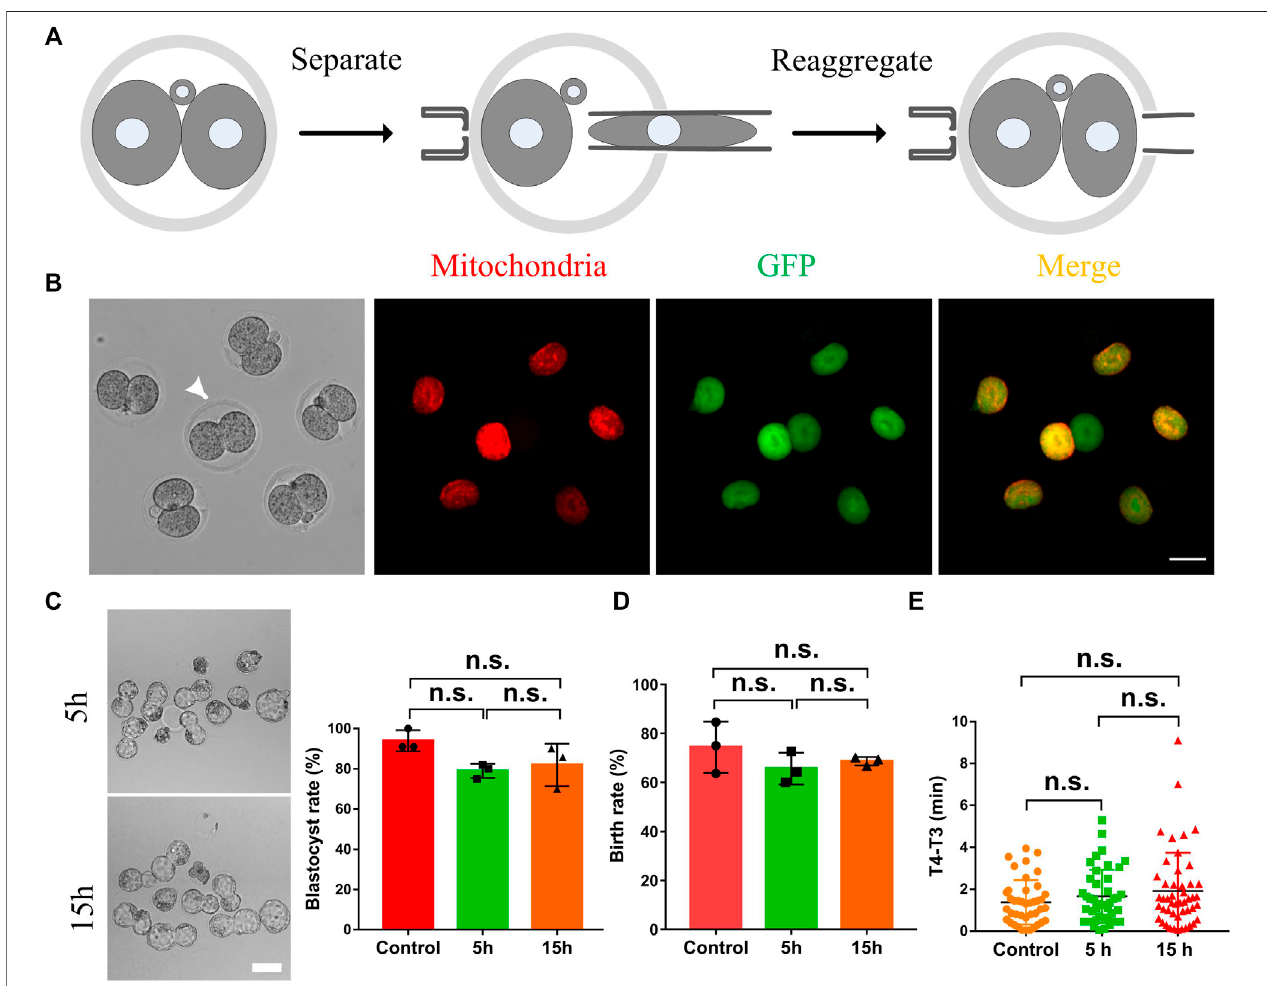
FIGURE 3 | The effects of the intercellular bridge on embryo development and cell synchronization. (A) The schematic diagram separates and re-aggregates daughtercellsina2-cellembryo.Thetwodaughtercellswere fi rstcompletelyseparatedbymicromanipulation,andthentheywereimmediatelyputbacktoreaggregate the embryos. (B) Representative fl uorescence images of the re-aggregated embryos. Arrows indicate embryos that have not been separated and re-aggregated as a control. Scale bar (cid:1) 50 μ m. (C) Representative images and statisticsof blastocysts developed from 2-cell embryos which were separated and reassembled at fi ve and 15 h after the formation of 2-cell embryos. Scale bar (cid:1) 100 μ m. (D) Statistical analysis of the birth rate generated from 2-cell embryos which were separated and reassembled at fi veand 15 h after theformationof2-cellembryos. (E) Thetime interval(T4-T3)betweenthe3-cell stage and the4-cellstage oftheembryoswhich were conducted with a separation and reaggregation at fi ve and 15 h after the formation of 2-cell embryos. Each experiment was replicated three times, n (cid:1) 30 – 34 for (C) , 36 – 40 for (D) , and 46 – 52 for (E) . The data are expressed as mean ± SEM and analyzed by two-tailed Student ’ s t-test. Statistically signi fi cant values of p > 0.05 indicate as no signi fi cance